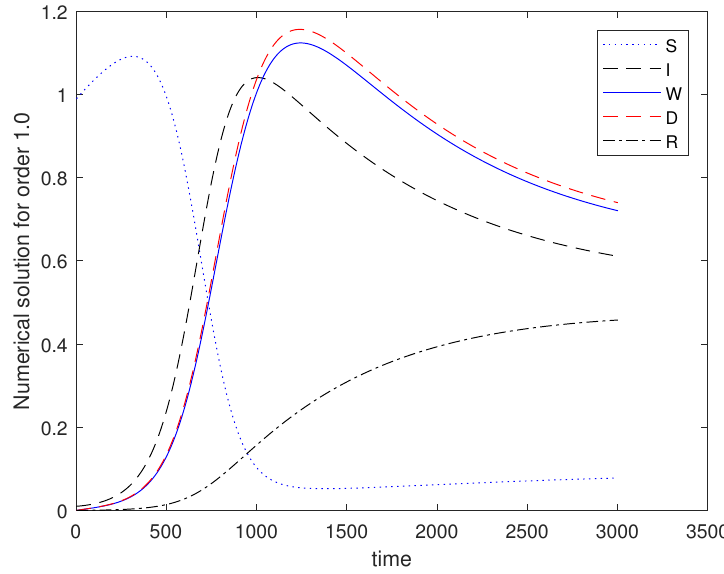
Figure 1. The computational results for the order 1 are compared with the solution for fractional order 0.99.